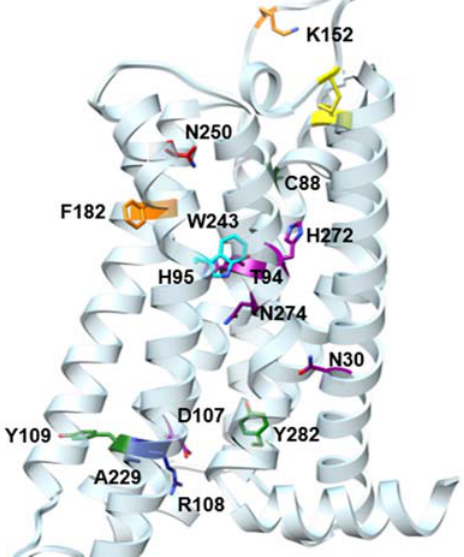
Figure 3. Summary of available hA 3 AR mutagenesis studies [14–16]. The color code is: green, mutation site affecting only agonist binding; orange, mutation site affecting only antagonist binding; purple, mutation site affecting both agonist and antagonist binding; blue, mutation site producing constitutively active mutants; red, Asn250 (6.55); cyan, Trp243 (6.48). The conserved TM3 ‐ EL2 disulfide bridge is also highlighted (yellow sticks). The residue Ballesteros–Weinstein notation [32] is: Asn30 (1.50), Cys88 (3.30), Thr94 (3.36), His95 (3.37), Asp107 (3.49), Arg108 (3.50), Tyr109 (3.51), Lys152 (EL2), Phe168 (EL2), Phe182 (5.43), Ala229 (6.34), Trp243 (6.48), Asn250 (6.55), His272 (7.43), Asn274 (7.45), and Tyr282 (7.53). TM, transmembrane α‐ helix.